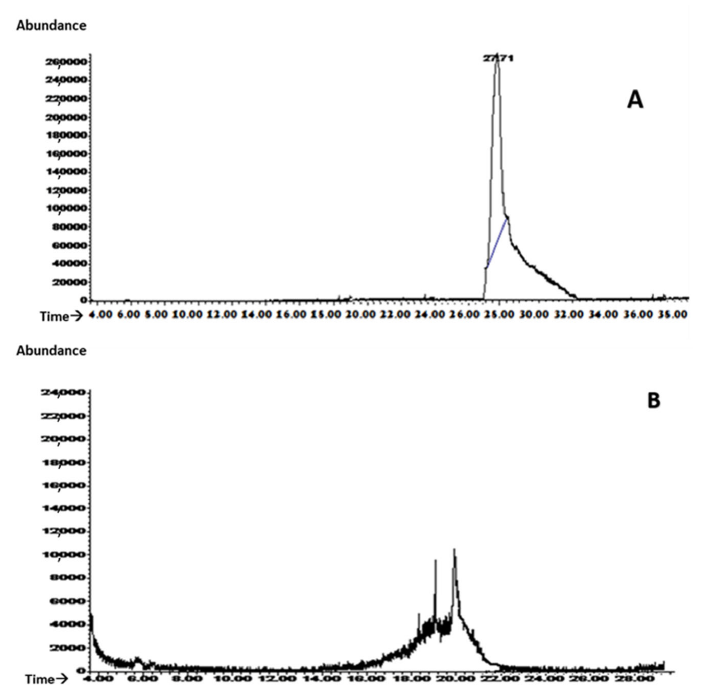
Figure 6. Evaluation, through GC/MS analysis, of phloretin released, after approximately 30 min, from acid gallic-based microspheres ( A ) and from a solution ( B ) under the same conditions.